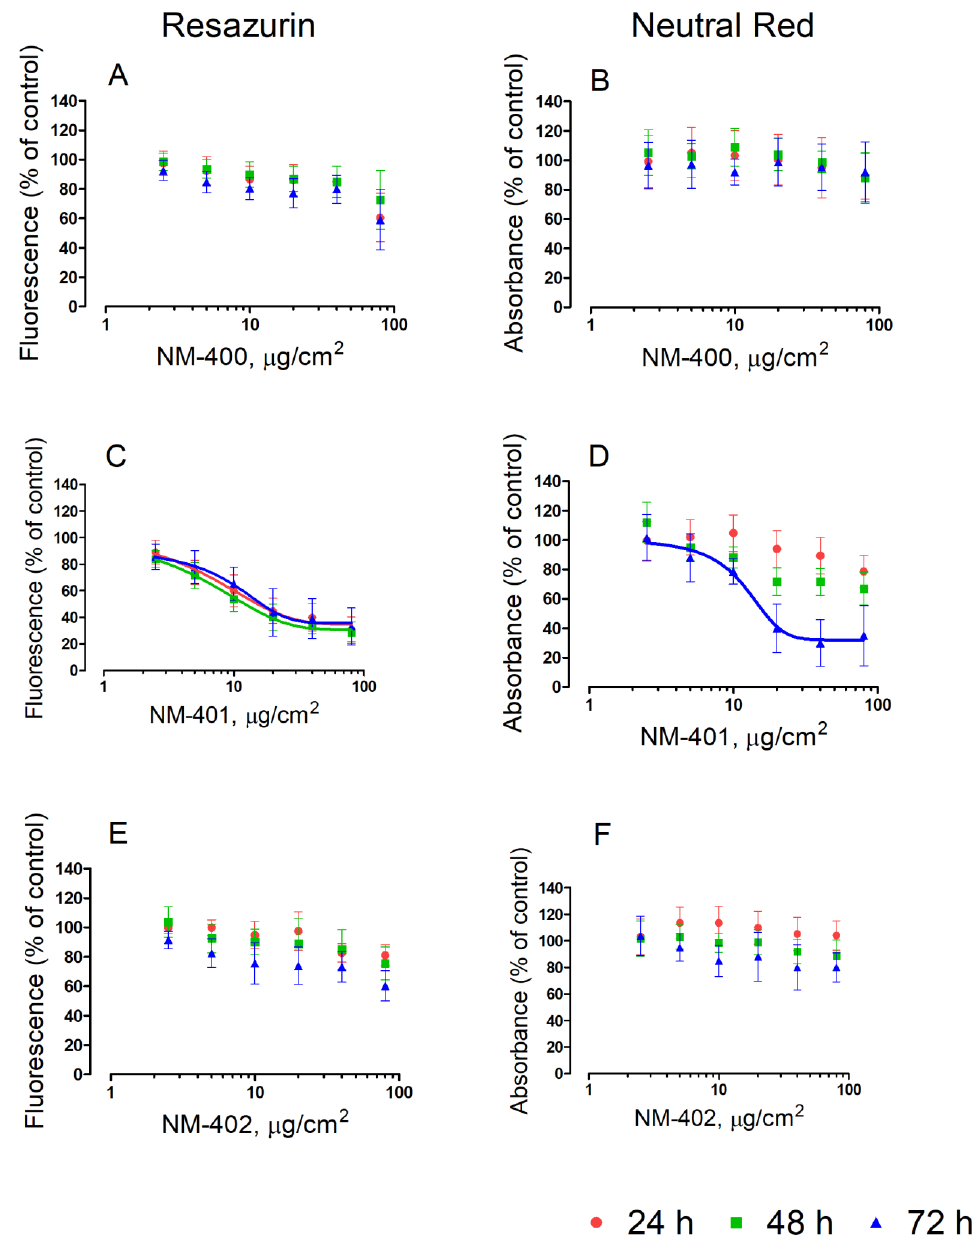
Figure 1. Effects of MWCNT on Raw264.7 murine macrophages. Cells were grown for 24 h in complete growth medium and then exposed for 24 h, 48 h, and 72 h to the indicated doses of MWCNT. At the end of the incubation, cell viability was assessed with resazurin ( A , B , C ) or neutral red uptake assays ( B , D , F ). Data are the means ± SD of five independent determinations. Lines represent the best fit to the dose-response curve (variable slope). For dose-response curves with NM-401, the R 2 values were 0.996, 0.999, and 0.993 at, respectively, 24 h, 48 h, and 72 h (resazurin); and 0.981 at 72 h (neutral red).